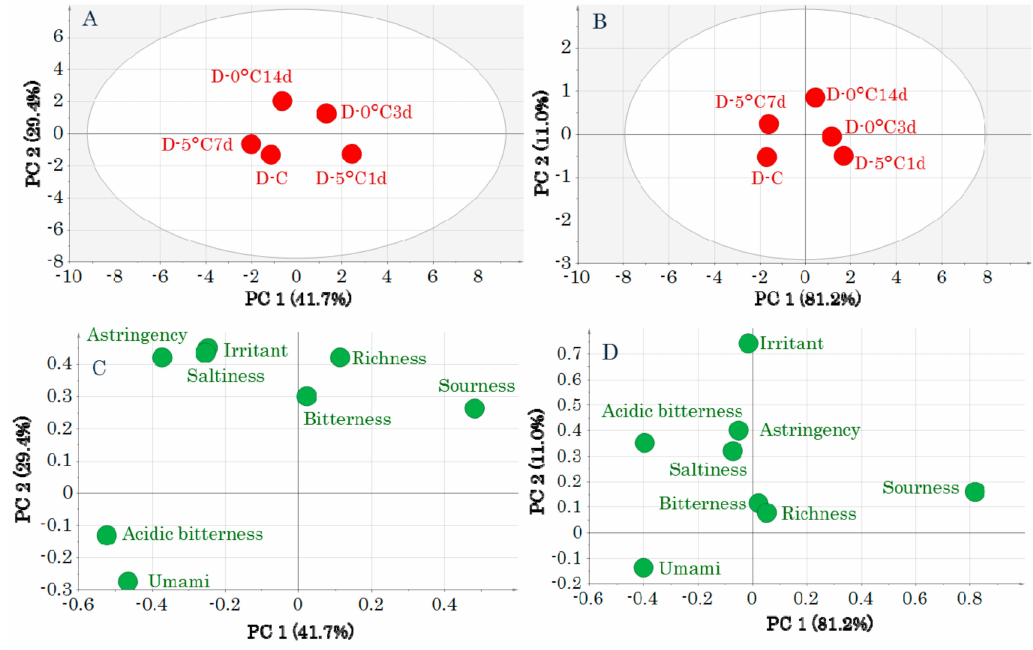
Figure 2. Score plots ( A , B ) and loading plots ( C , D ) obtained by a principal components analysis of taste-attribute profiles in dark muscle samples. Data were pretreated with unit variance scaling ( A , C ) and pareto scaling ( B , D ). Symbols in score plots ( A , B ) indicate sample IDs (Table